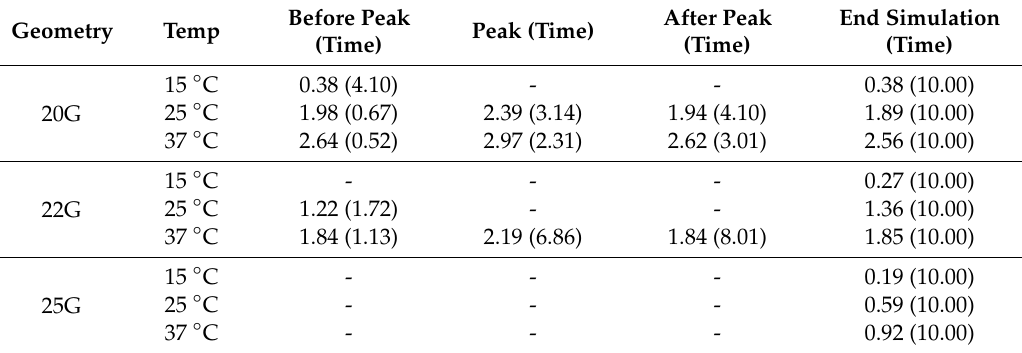
Table 4. Maximum outlet velocities values (cm/s) and time (s).